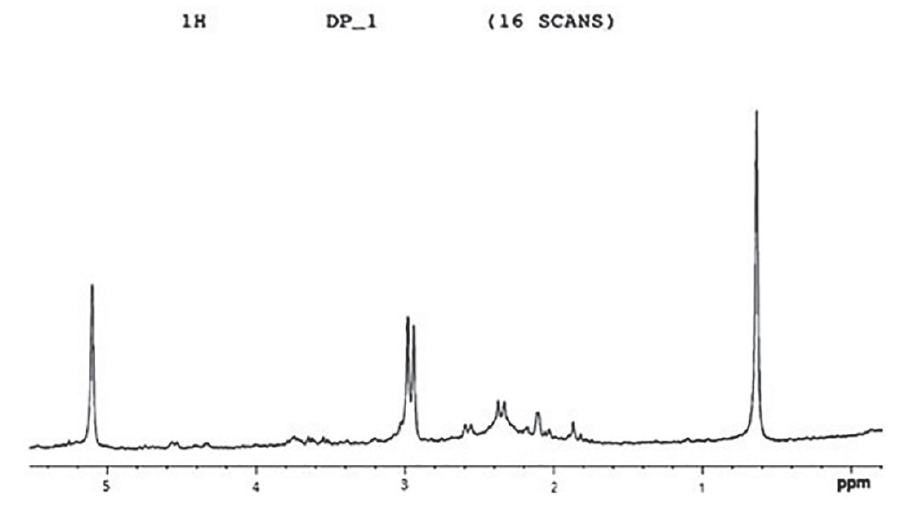
FIGURE 4 - 1 H NMR of DP-1 isolated from methanol extract of D. pentaphylla